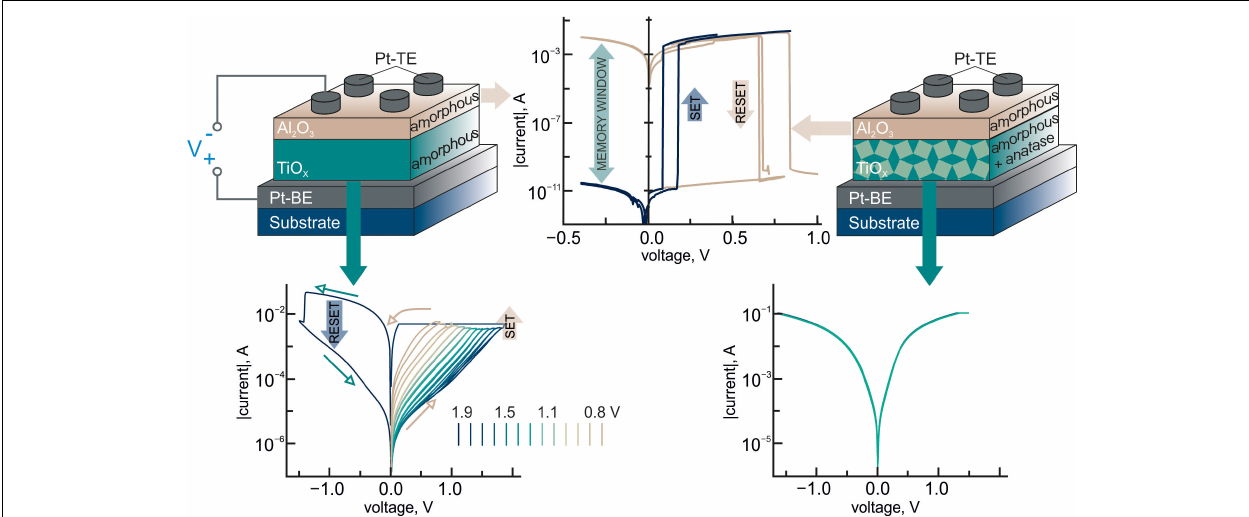
FIGURE 1 | Schematic illustration of Pt/TiO 2 /Al 2 O 3 /Pt bilayer structures with amorphous titanium dioxide layer (on the left) and bilayer structures with amorphous titanium dioxide layer with the inclusion of the anatase phase crystallites (on the right). The experimental I-V characteristics of Pt/TiO 2 /Pt structures with gradual resistance tuning in the range of three orders of magnitude (on the left) and without any resistive effects (on the right). Experimental I-V characteristics of the resistive switching in Pt/Al 2 O 3 /Pt structures determining the memory window in the bilayers of seven orders of magnitude are shown in the